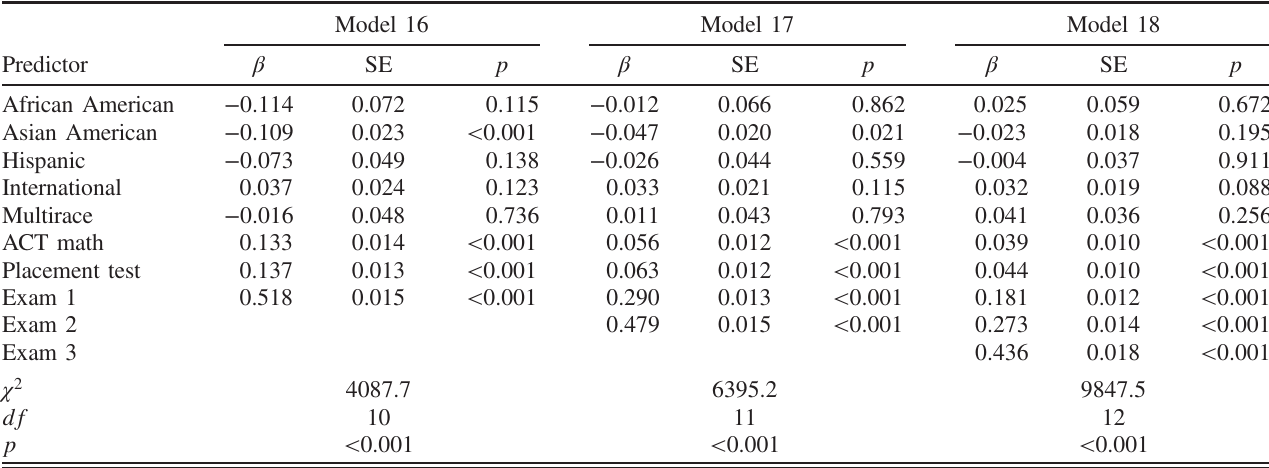
TABLE XIII. Models with course exam scores predicting physics 1 final exam scores, fall